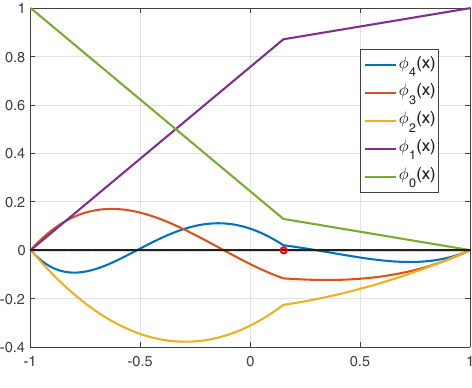
Figure 1. IFE basis functions on a reference element